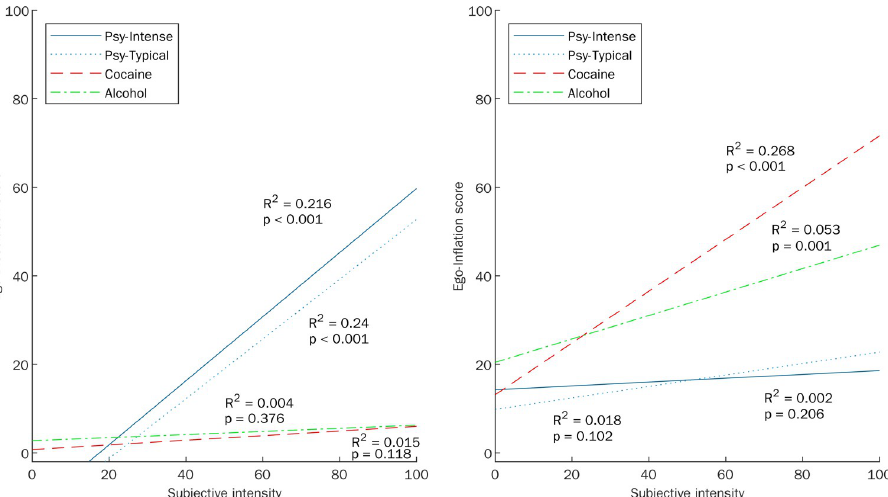
Fig 3. Relationship between (A) ego-dissolution or (B) ego-inflation, respectively, and subjective intensity compared across different drug experiences. This figure reproduces the results reported by Nour et al. [16] for intense hallucinogen experiences (solid blue line), typical hallucinogen experiences (light blue dotted line), cocaine experiences (red dashed line), and alcohol experiences (green dash-dot line). Intensity of the experience was rated on a visual analog scale, ranging from 0 (“not at all”) to 100 (“the most intense imaginable” for hallucinogens, “the most energized / wired imaginable” for cocaine, “the most inebriated / drunk imaginable” for